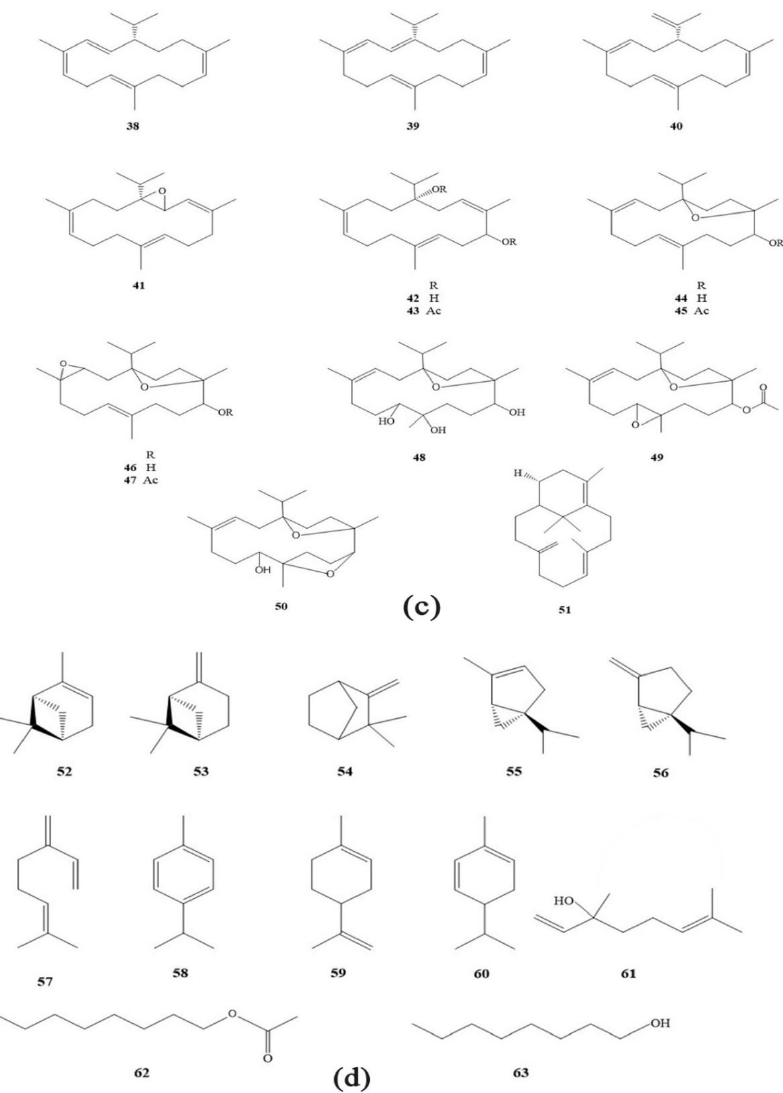
Figure 1. The structural patterns of some chemical constituent in frankincense. ( a ) Pentacyclic triterpenoids; ( b ) tetracyclic triterpenoids; ( c ) macrocyclic diterpenoids; ( d ) essential oils.